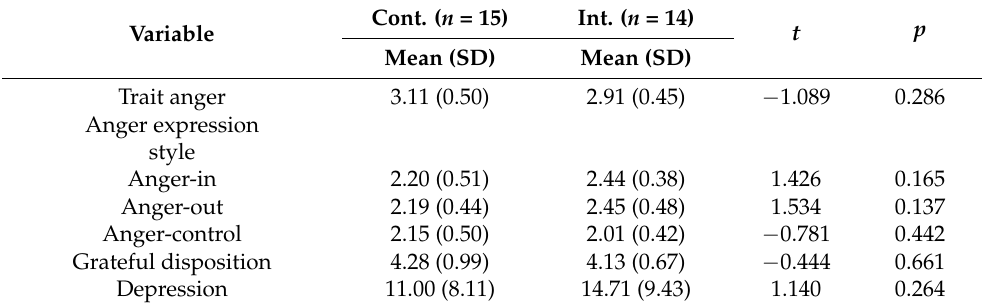
Table 3. Homogeneity test results for dependent variables between control and intervention groups.